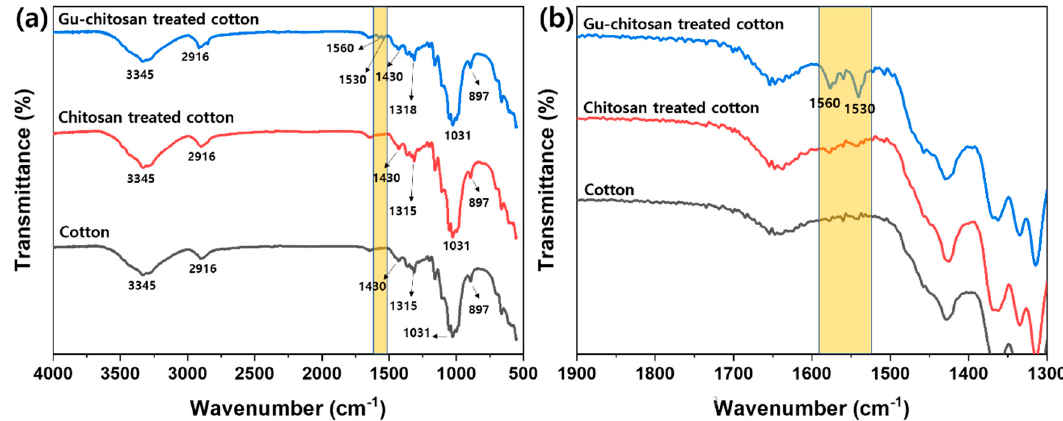
Figure 6. FT-IR spectra of the untreated, chitosan-treated, and Gu-chitosan-treated cotton fabrics: ( a ) FT-IR spectrum in the 4000 cm − 1 to 500 cm − 1 range and ( b ) FT-IR spectrum expansion in the 1900 cm − 1 to 1300 cm − 1 range.